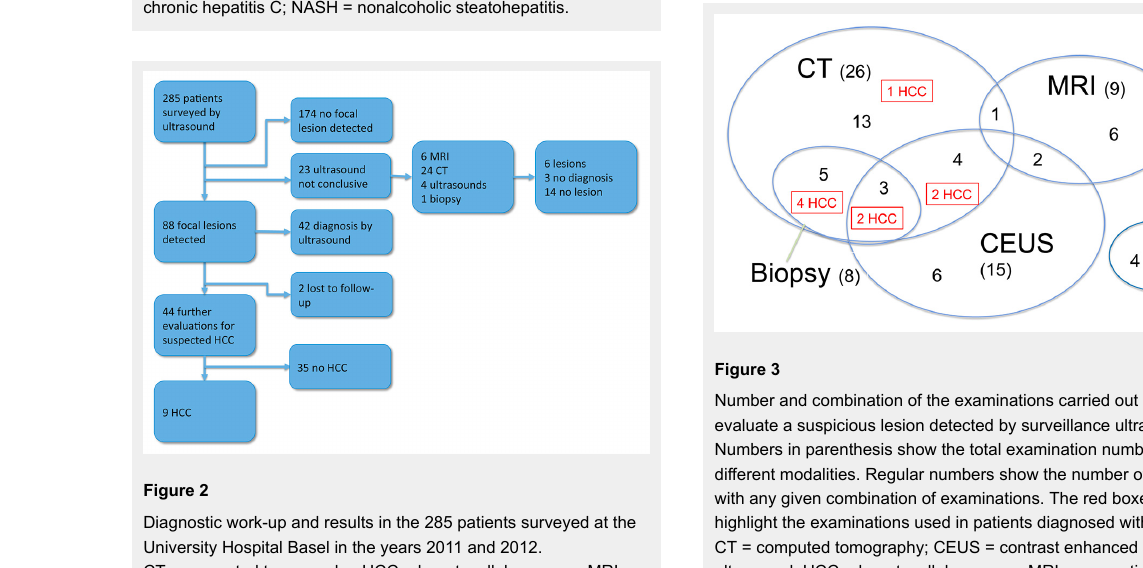
Frequency of underlying liver disease of the patients included in the surveillance cohort.